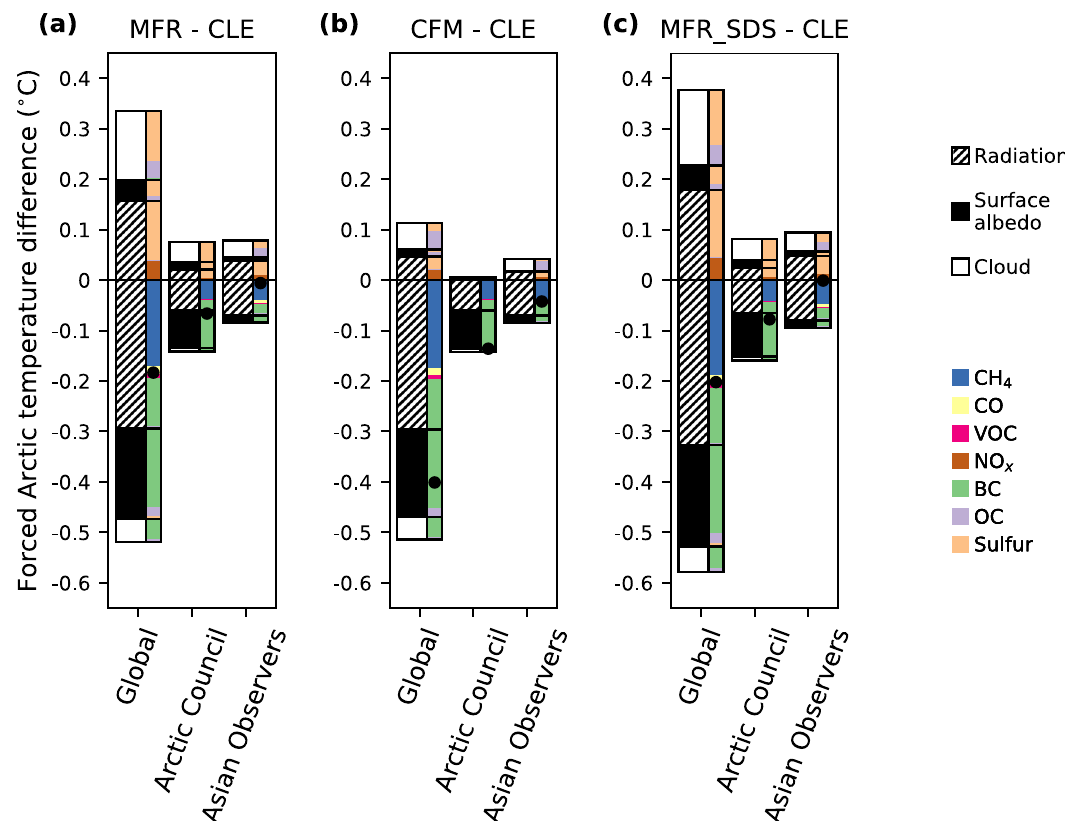
Fig. 3 Impacts of changes in air pollution on future Arctic climate. a Differences in forced Arctic temperatures in 2050 are shown between Maximum Feasible Reduction, b Climate Forcing Mitigation, Sustainable Development activity ( c ) scenarios and the Current LEgislation scenario. The differences are broken down into contributions of global and regional emissions of chemically reactive species and the radiative forcing processes that are associated with these emissions. 3 different radiative forcing processes are considered, indicated by wide bars (hatched, black, and white; for interactions of air pollutants and CH 4 with radiation, surface albedo, and clouds, respectively, see legend). Narrow colored bars refer to emissions of 7 reactive species (see legend) from global sources and two regions (Arctic Council, and Asian Arctic Council Observer countries: Japan, People ’ s Republic of China, Republic of India, Republic of Korea, Republic of Singapore). Black bullets refer to the net temperature changes associated with global and regional emissions. Supplementary Fig. 10 provides the corresponding global temperature